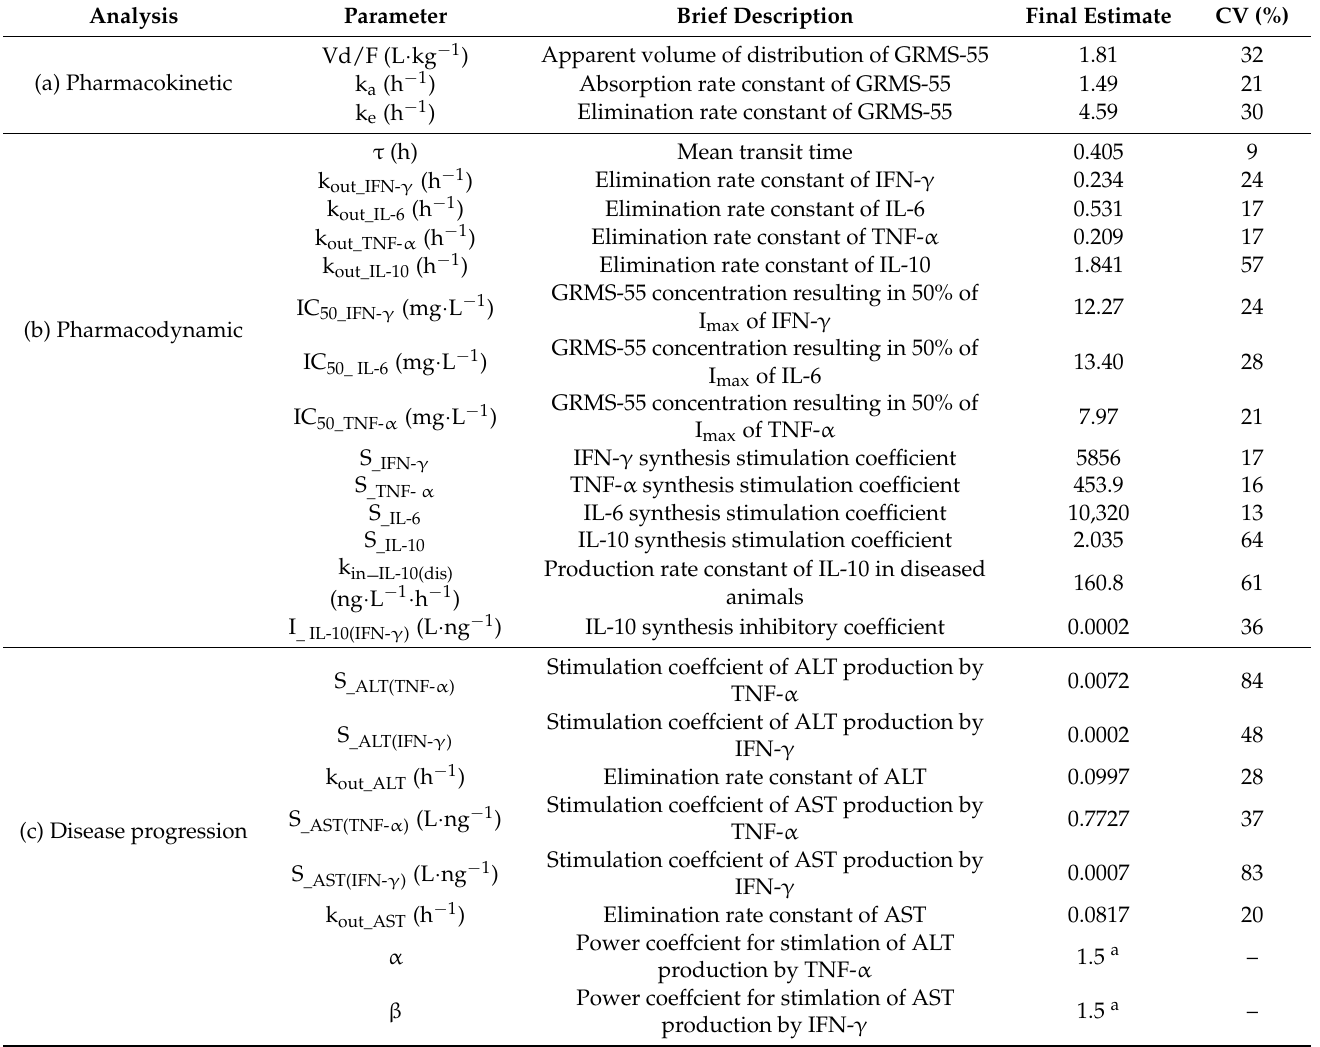
Table 1. Values of parameters of the PK/PD disease progression model. ( a ) Pharmacokinetic, ( b ) pharmacodynamic, and ( c ) disease progression parameters of GRMS-55 administered to BALB/c mice at single IP doses of 50 or 100 mg · kg − 1 . Mice in the PD/disease progression study were challenged with ConA at an IV dose of 20 mg · kg − 1 30 min following GRMS-55